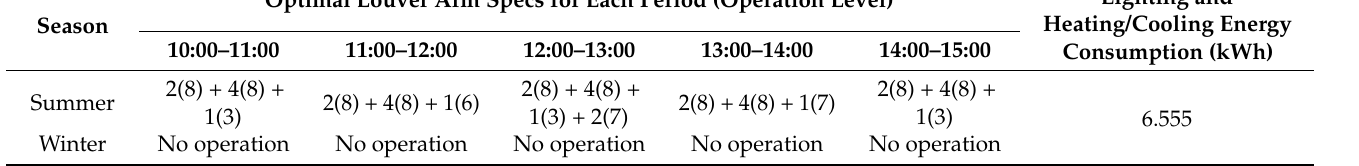
Table 8. Optimal specifications for the proposed STML system for saving energy.